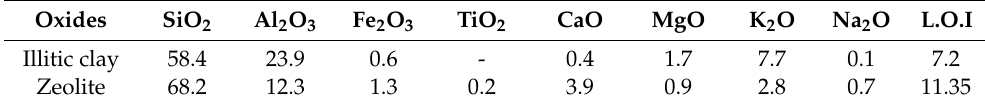
Table 1. Chemical composition of illitic clay and natural zeolite (in wt.%). Oxides SiO 2 Illitic